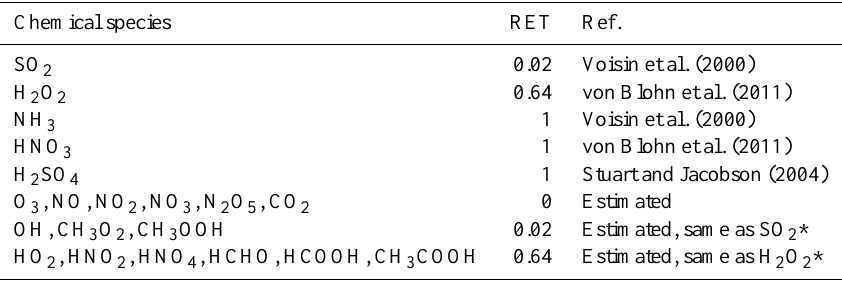
Table 4. Retention